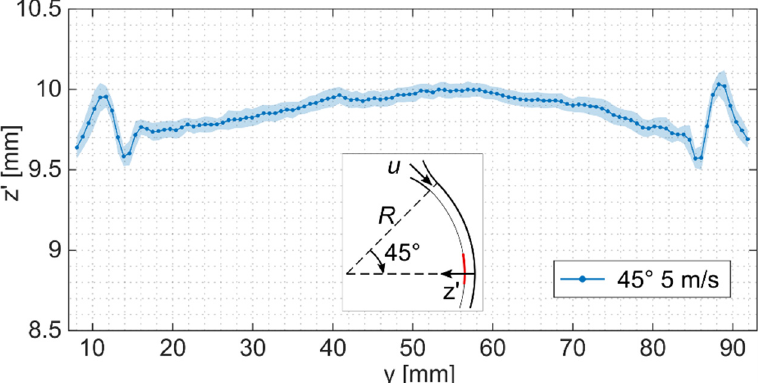
Figure 5. Height profile of the undisturbed flow at u = 5 m/s, β = 45° downstream of the nozzle. The standard deviation is represented as the area behind the line.